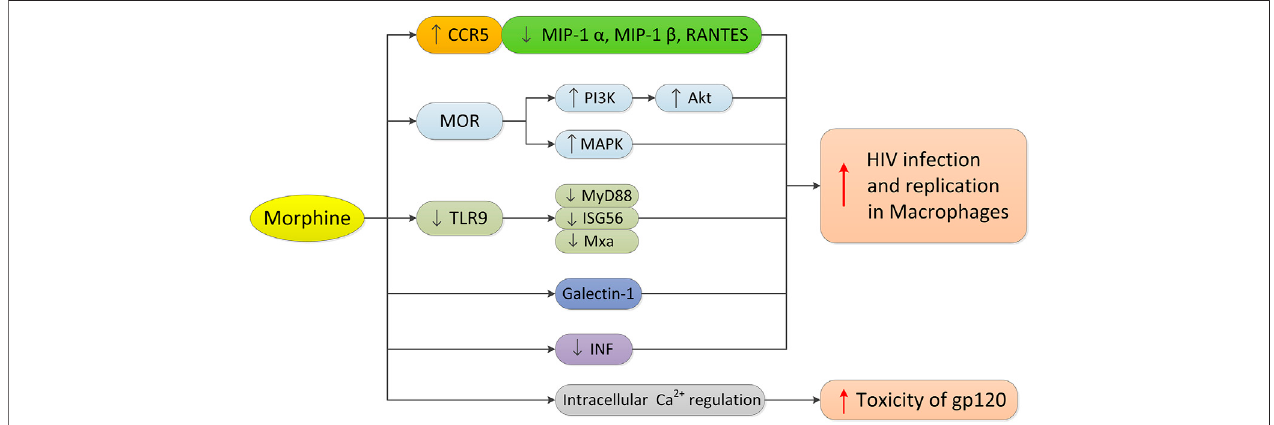
FIGURE3| Morphine ’ smechanism inregulatingHIV infectioninmacrophages. Morphinepromotestheinfectionand replication ofHIVinmacrophages asfollows: 1) upregulating the expression of CCR5 and downregulating the expression of CCR5 competitive ligand in macrophages; 2) activating MOR, PI3K/Akt and MAPK signaling pathways; 3) inhibiting the TLR9 pathway and down-regulating the expression of MyD88, ISG56 and Mxa; 4) increasing the expression of Galectin-1; and 5) signi fi cantlyinhibitingtheinterferonsignalingpathwayandinterferon-inducedgeneexpression,anddestroyingtheinherentantiviralmechanismofmacrophages.In addition, morphine can enhance the cytotoxicity of HIV-1 virus protein gp120 through intracellular calcium